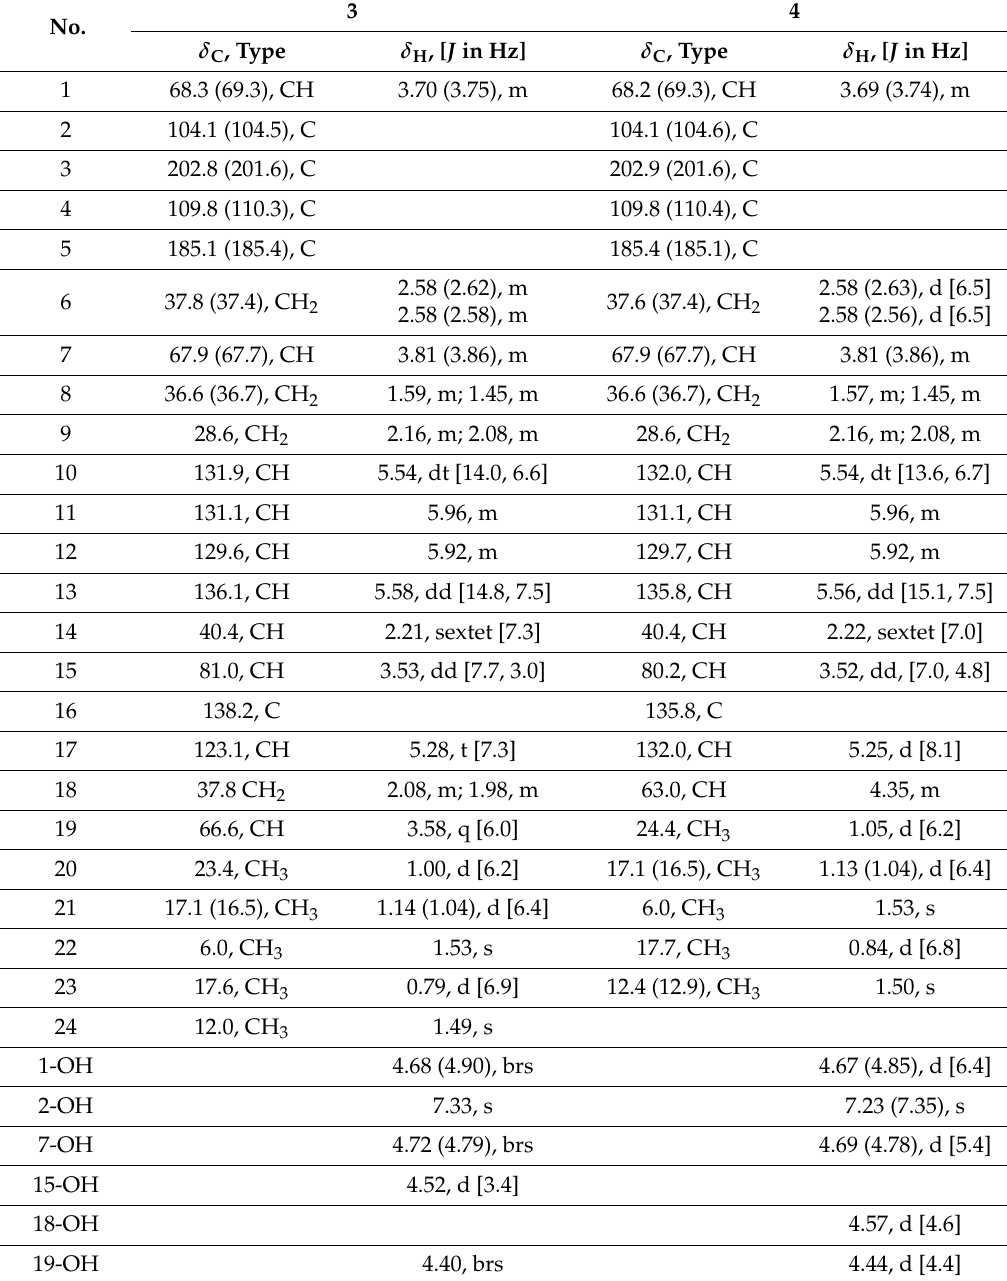
Table 2. 1 H-NMR (600 MHz) and 13 C-NMR (150 MHz) data of compounds 3 and 4 in DMSO- d 6